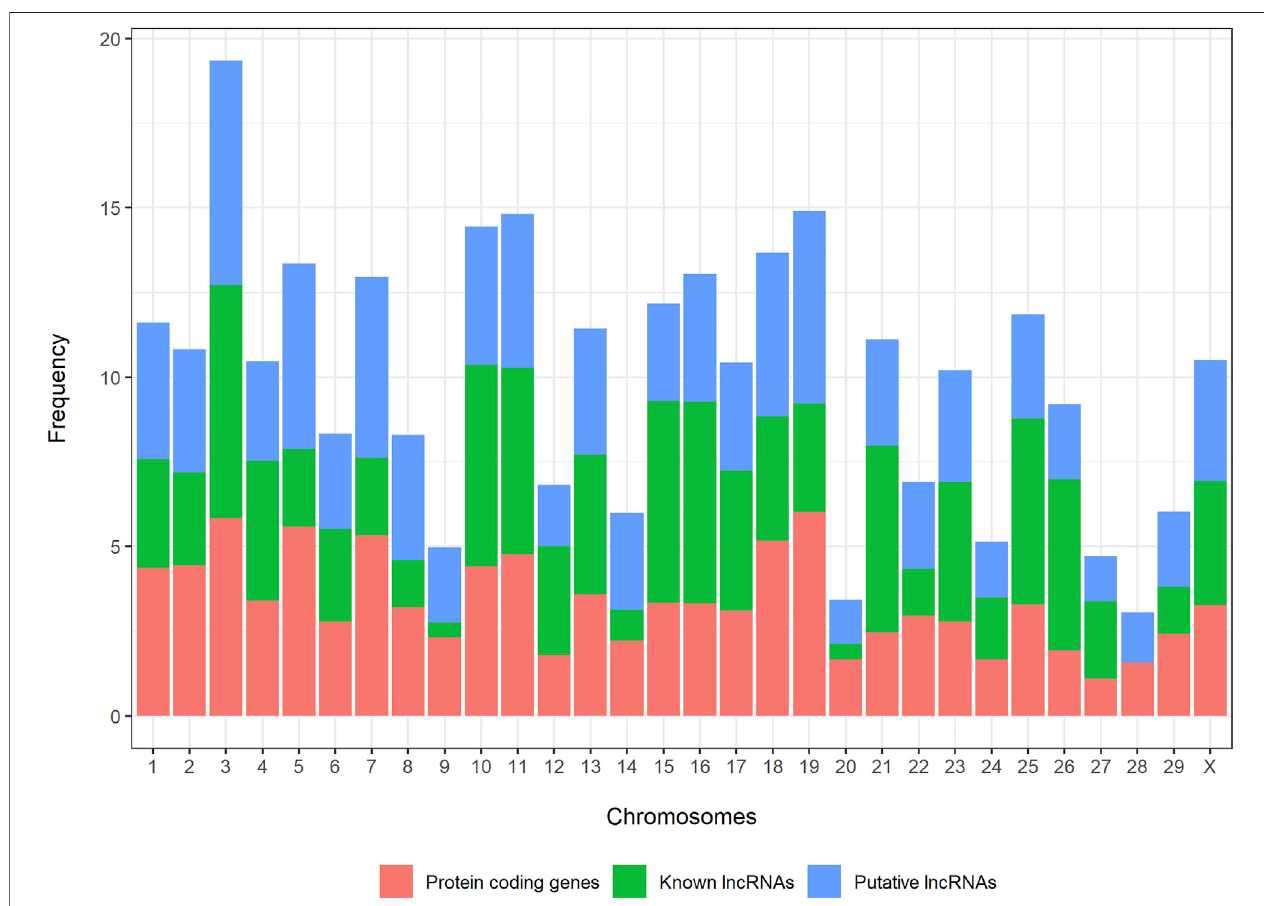
FIGURE 2 | Distribution of novel long noncoding RNAs, known long noncoding RNAs, and protein-coding genes across the bovine genome.